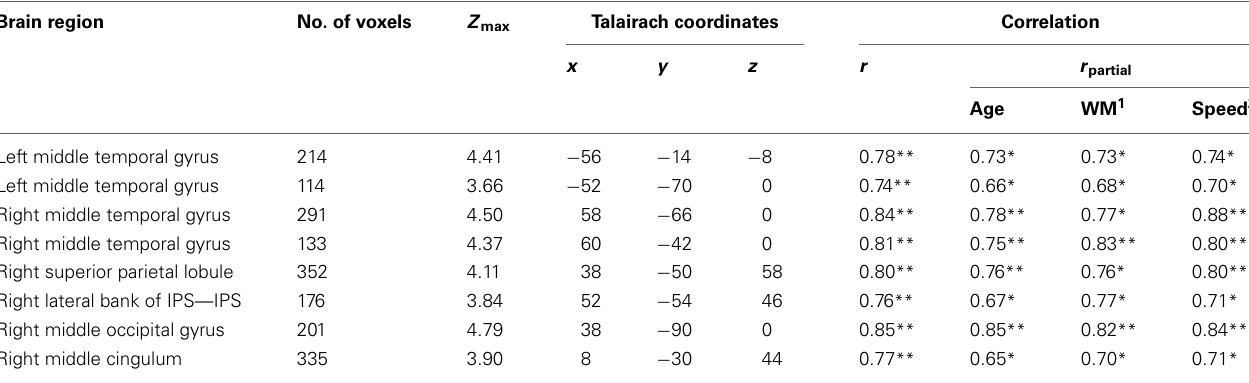
Table 2 | Brain areas that showed significant positive correlations with individual behavioral indexes of selective susceptibility to numerical proximity (dRT